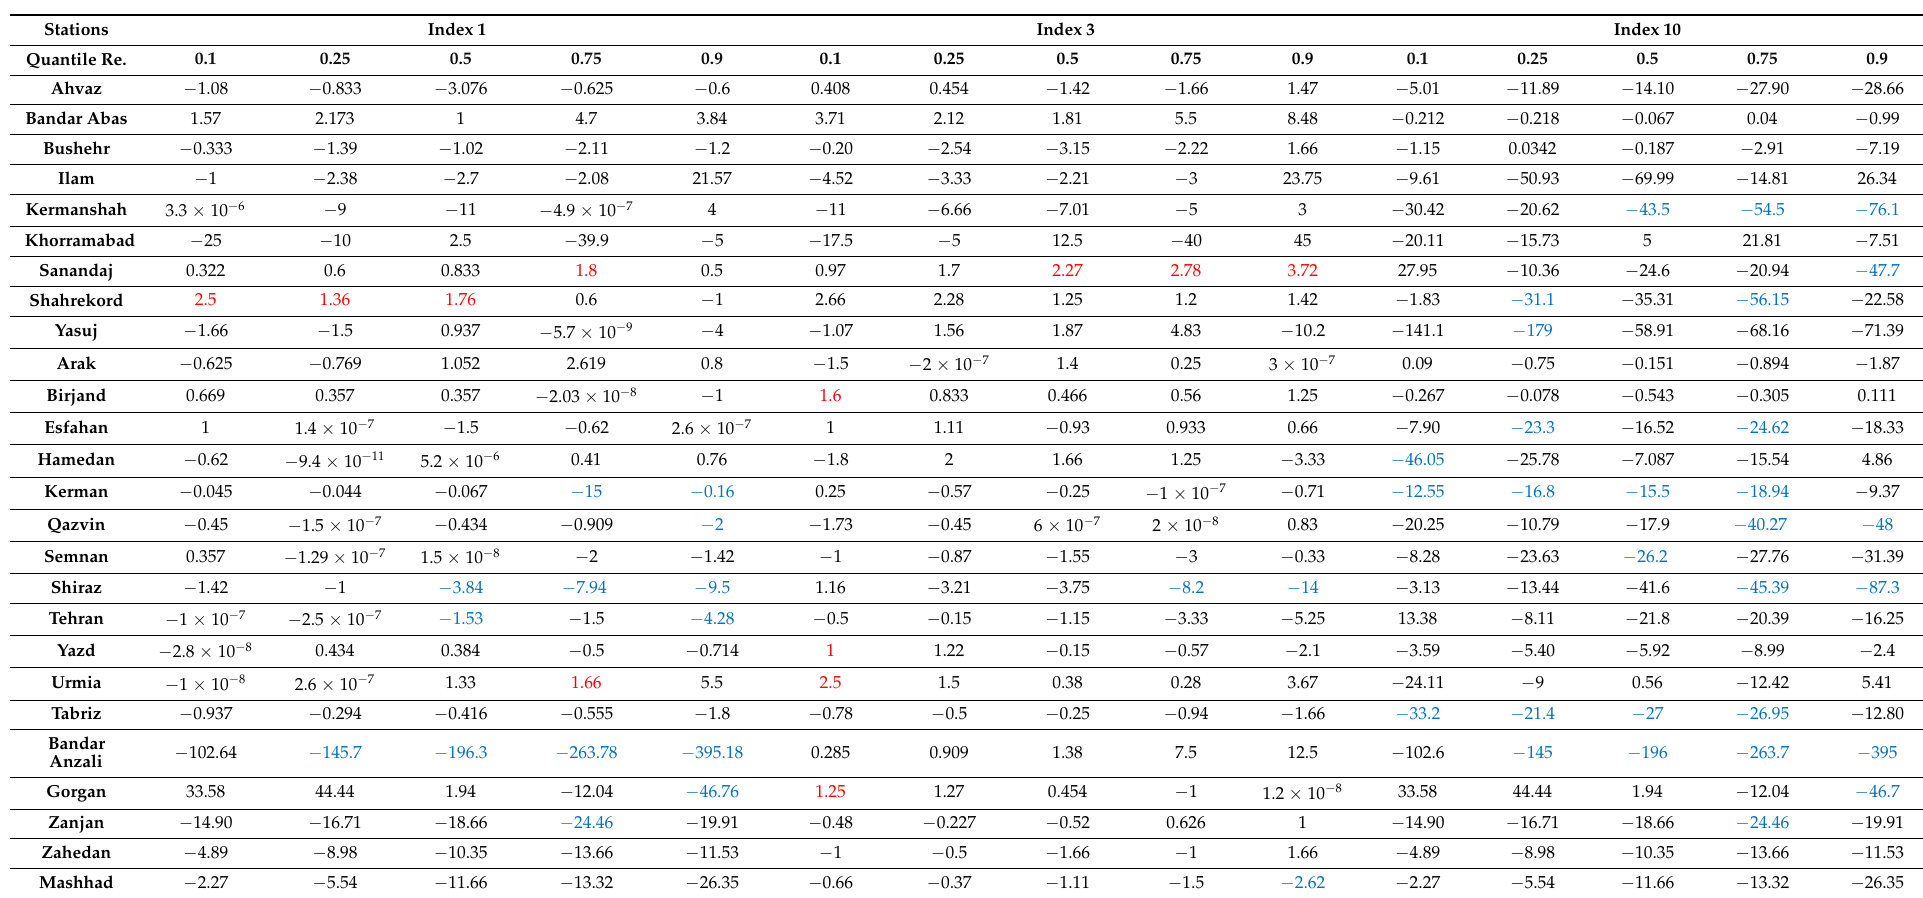
Table 5. The quantile regression coefficients of the precipitation and temperature for the selected percentiles ( × 10 − 2 ). Blue and red numbers denote statistical significance at the 0.05 critical level downward and upwards